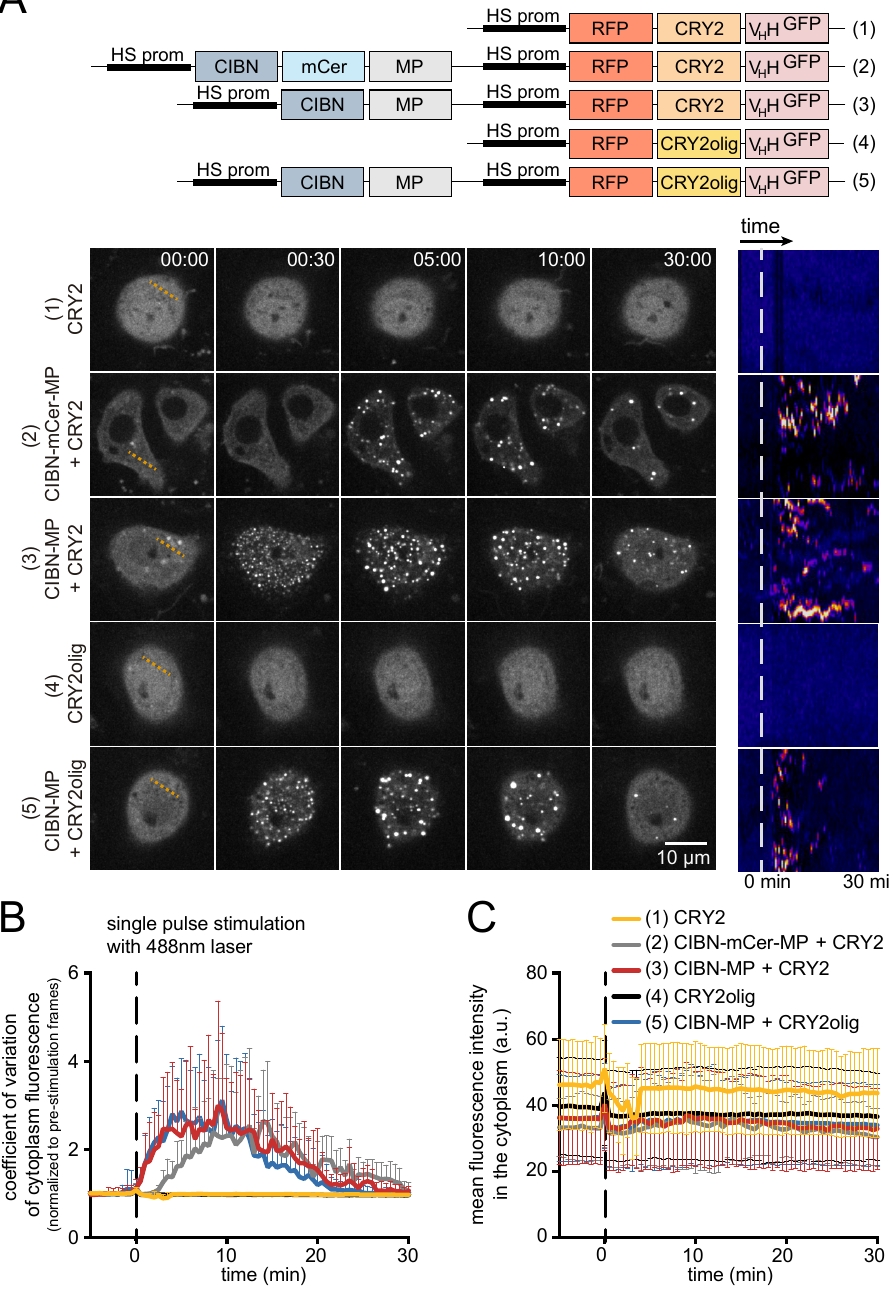
Figure 3. A Drosophila S2 cell LARIAT toolbox. ( A ) Representative timepoints and Z-sections of Drosophila S2 cells expressing the indicated LARIAT modules. Transfected cells were kept in the dark prior to live-imaging. Pseudo-colored kymographs made along the orange dashed lines represent cluster formation and disassembly after stimulation with a 488 nm laser set to 1 mW laser power for 300 msec at minute 0 (white dashed line). ( B ) Clustering was quantified with the coefficient of variation of cytoplasm fluorescence and ( C ) mean fluorescence intensity was plotted along time. Graphs display mean ± standard deviation (SD). n (CRY2) = 9 cells, n (CIBN-mCer-MP+CRY2) = 5 cells, n (CIBN-MP+CRY2) = 15 cells, n (CRY2olig) = 10 cells, n (CIBN-MP+CRY2olig) = 13 cells.